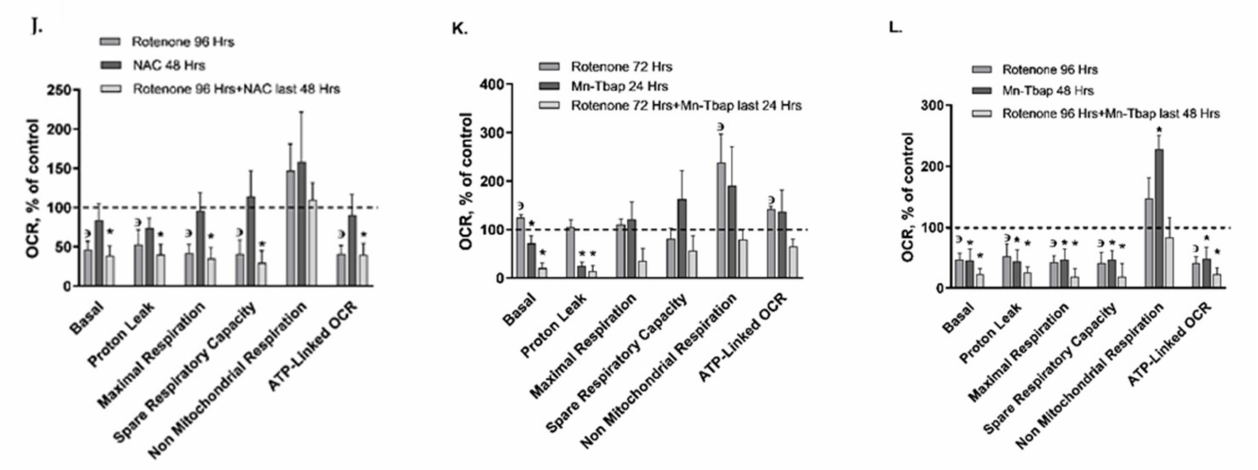
Int. J. Mol. Sci. 2021 , 22 , x FOR PEER REVIEW Figure 2. Effect of ROS scavengers/autophagy enhancers on mitochondrial respiration parameters pre and post exposure to 10 pM rotenone for 72 ( A,C,E,G,I,K ) or for 96 ( B,D,F,H,J,L ) h.